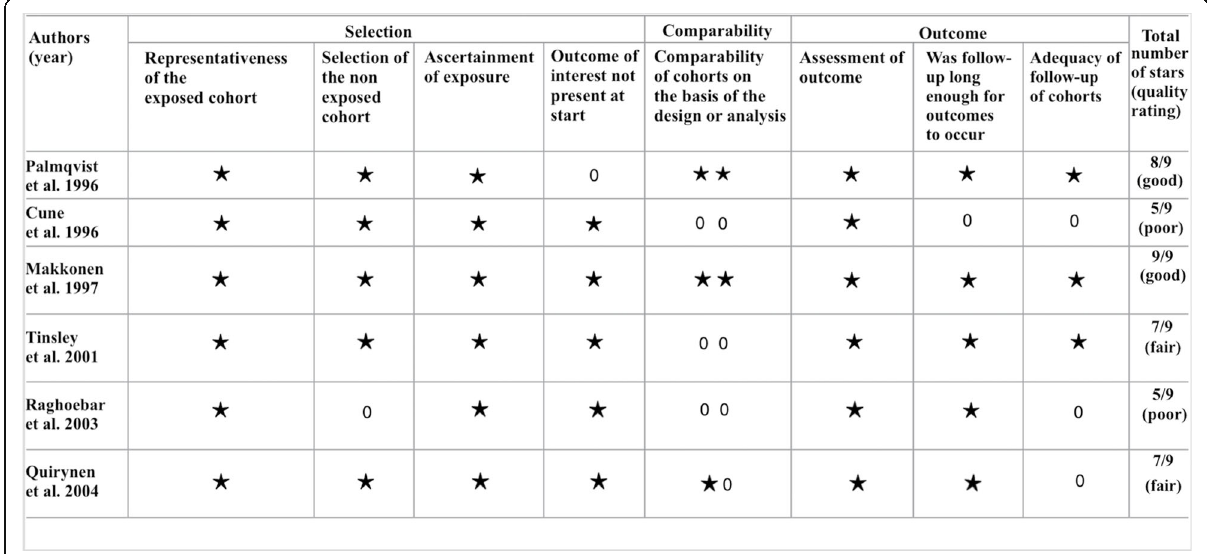
Fig. 2 Assessments of quality and risk of bias via the Newcastle-Ottawa Scale. For a better visualization, stars have been used to represent the scores in the